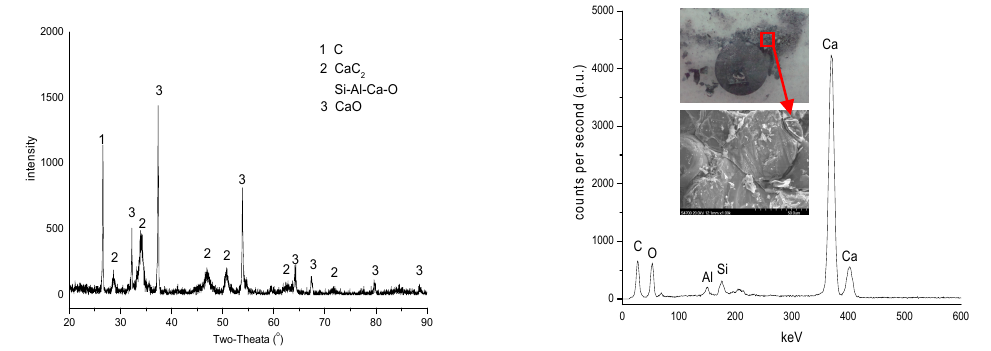
Ca Figure 4. SEM+EDX analyses : ( a ) CaO (1500 °C); ( b ) ash-C (1500 °C); ( c ) CaO (+ash-C,1500 °C); ( d ) ash-C (+CaO,1500 °C);